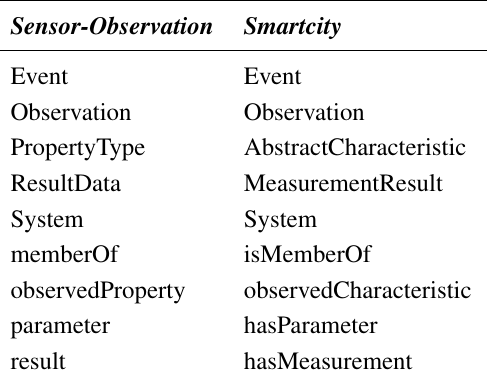
Table 5. Reference alignment for